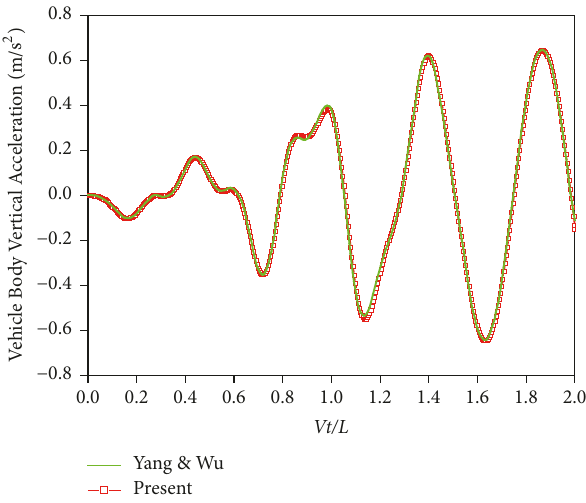
Figure 4: Vertical acceleration of vehicle